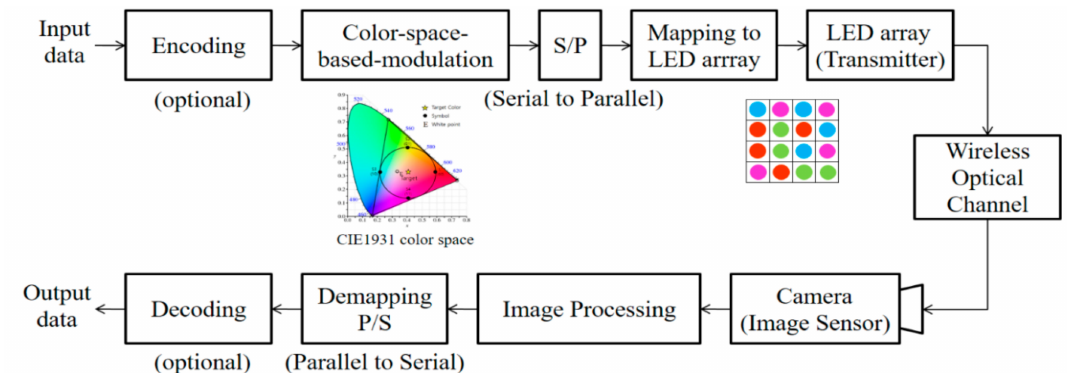
Figure 9. Color-independent visual MIMO transceiving process